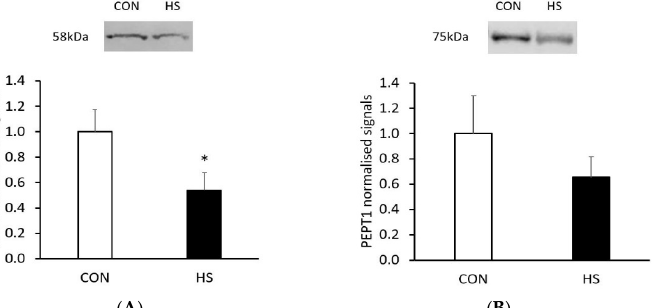
Figure 4. Relative protein expression of glucose transporter 2 (GLUT2; ( A )) and peptide transporter 1 (PEPT1; ( B )) in placentae between control (CON, n = 5) and heat stress (HS, n = 5) groups. Target protein expression was normalised to total protein loaded and expressed as normalised signals (arbitrary units). * p < 0.05. Error bars: standard error of the